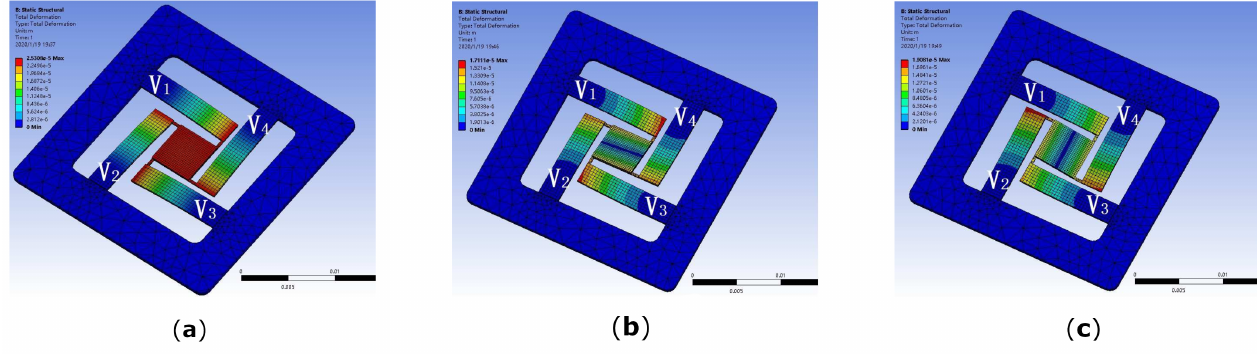
Figure 2. Three- degrees-of-freedom flexible piezoelectric nano-positioning stage. ( a ) Displacement Z . ( b ) Rotation angle θ . ( c ) Rotation angle ϕ . Table 1. Relationship between output of nano-positioning stage and voltage of piezoelectric actuators.